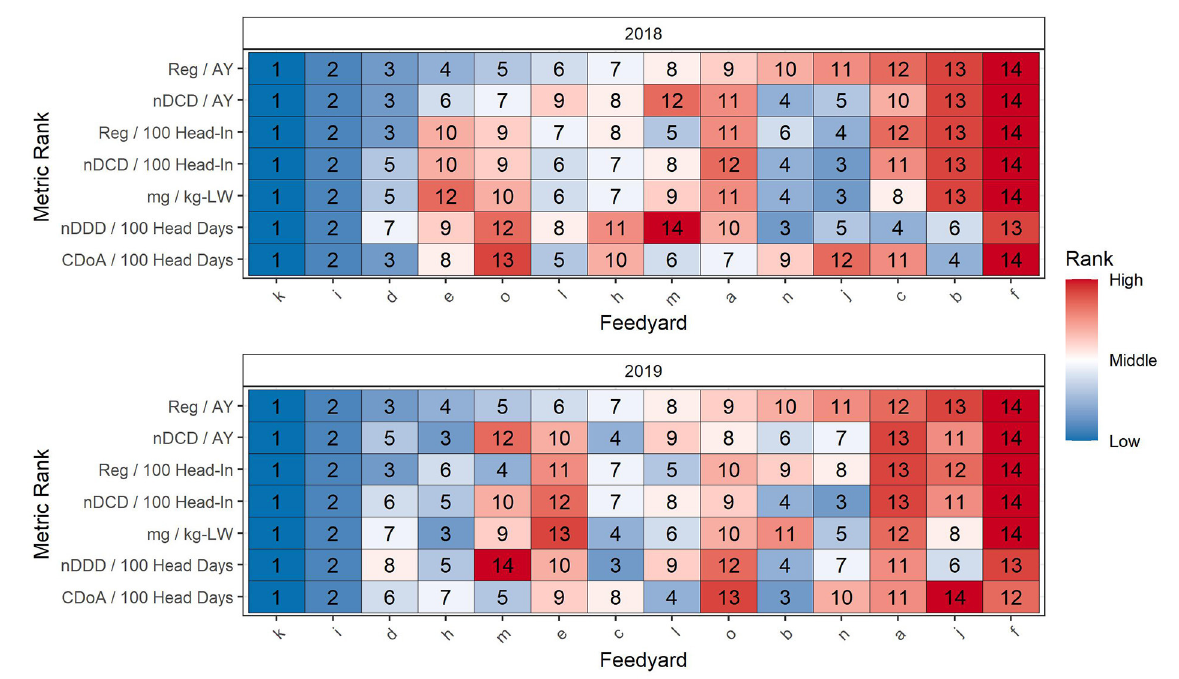
highest (28.6%) feedyards when feedyard rankings